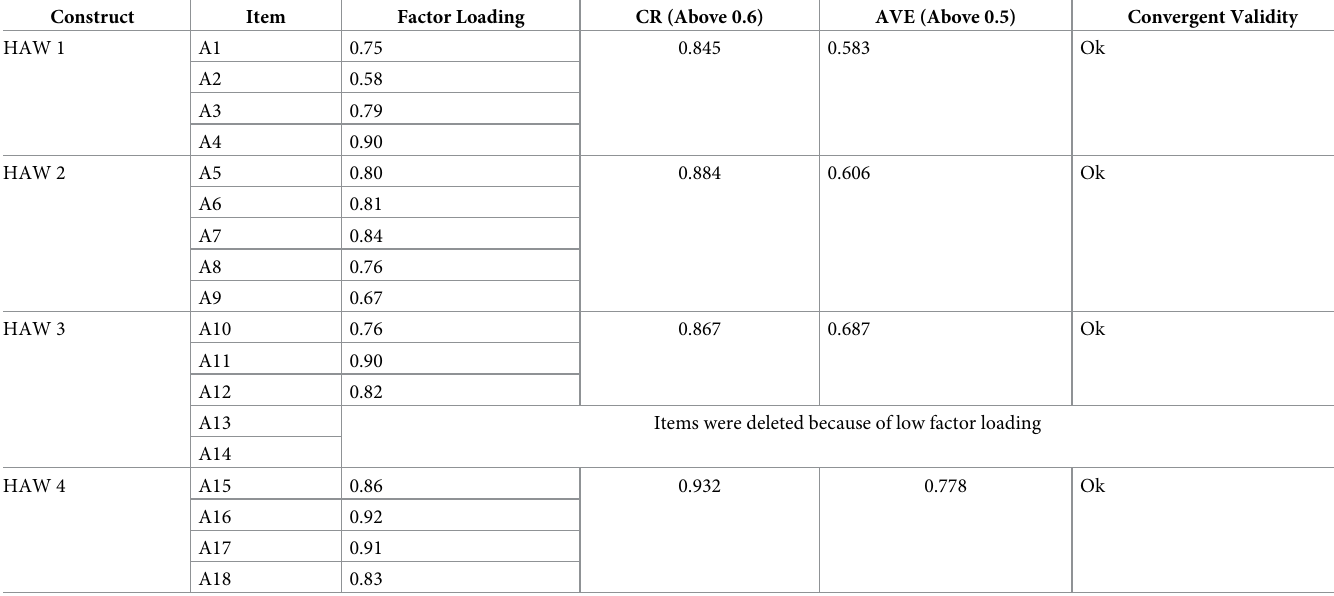
Table 11. The results of AVE and CR. Construct